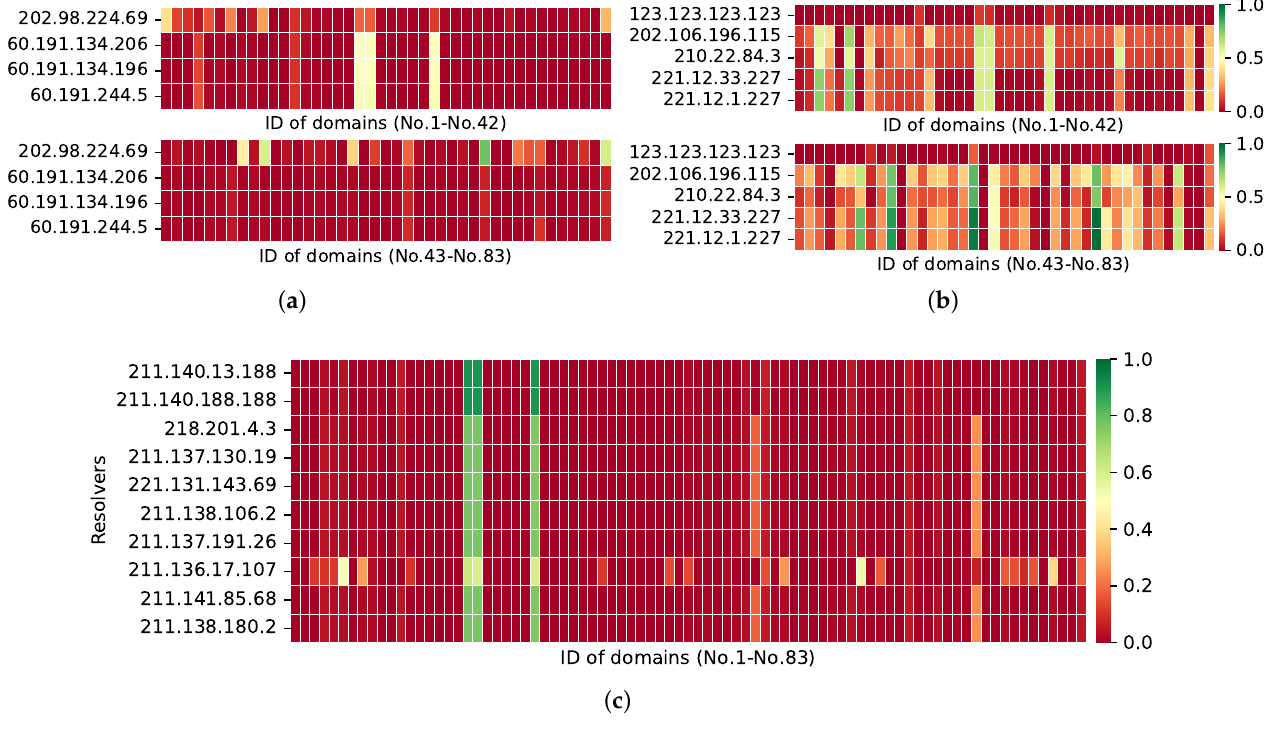
Figure 9. The correct rate of DNS resolvers responding to blocked domains for different ISP. ( a ) ISP Telecom; ( b ) ISP Unicom; ( c ) ISP Mobile. DNS filtering may affect resolvers from the same ISP in various countries inconsis- tently . As illustrated in Figure 9a, the ISP Telecom DNS resolver 202.98.224.69 in Tibet can correctly respond to the domain names windscribe.com and xvideos.es (with ACR values more than 0.7), while the Telecom DNS resolver in other regions replies to the domain names with a lower accurate rate. Similarly, the ISP Unicom DNS resolver in Beijing, 123.123.123.123, resolves all domains with an ACR value of less than 0.1, which is notably different from the other Unicom DNS resolvers (as seen in Figure 9b). Consistent responses from the same ISP and Location DNS resolvers . We discov- ered that, when we analyzed the responses of DNS resolvers from the same ISP in the same area, their accurate rates are nearly identical. For instance, Figure 10 depicts the correct response rates of seven ISP DNS resolvers (Telecom, Unicom, and Mobile in Zhejiang Province) to blocked domain names. This case means that clients in a region who use any DNS resolver provided by their ISP are similarly affected by DNS filtering. Additionally, it demonstrates once again that DNS is affected differentially by DNS filtering at the national level for different